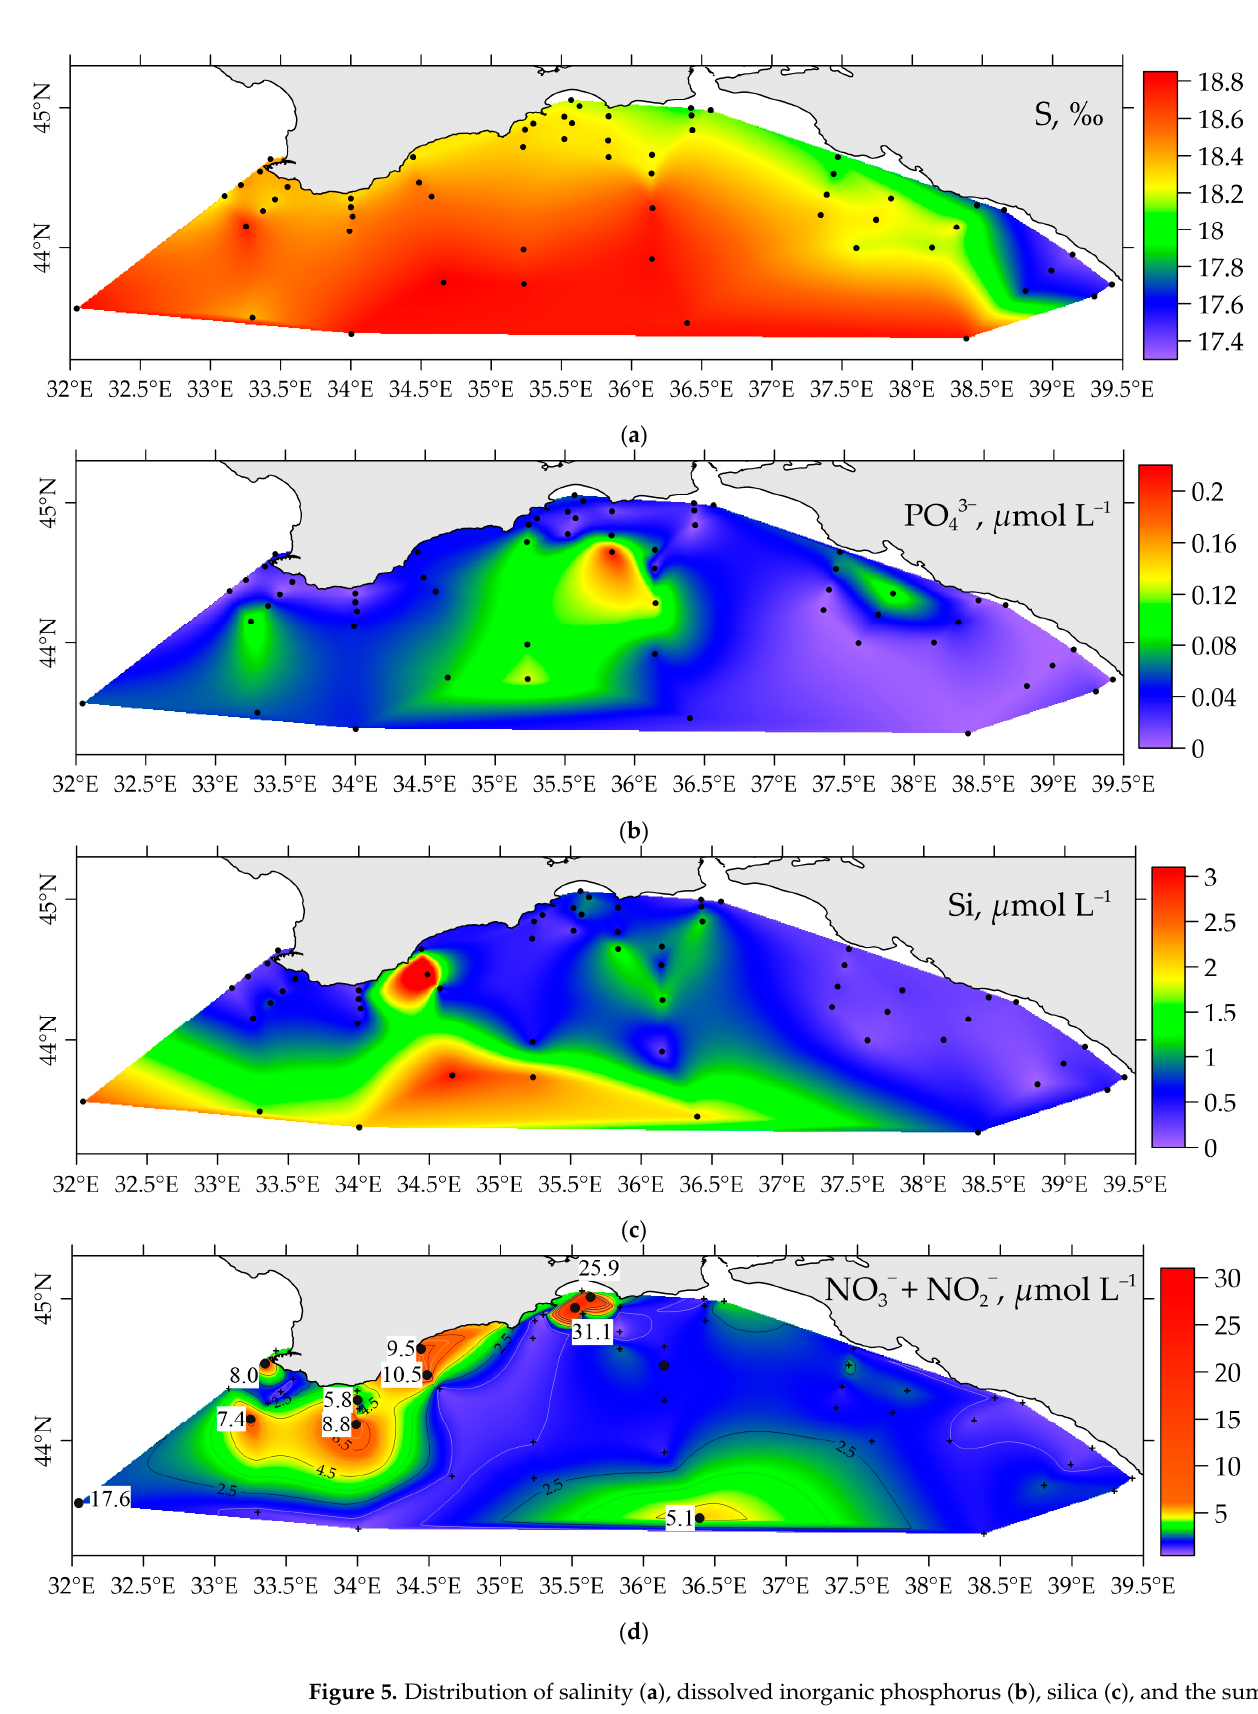
Figure 5. Distribution of salinity ( a ), dissolved inorganic phosphorus ( b ), silica ( c ), and the sum of nitrates and nitrites ( d ) in the surface layer of the Black Sea in April–May